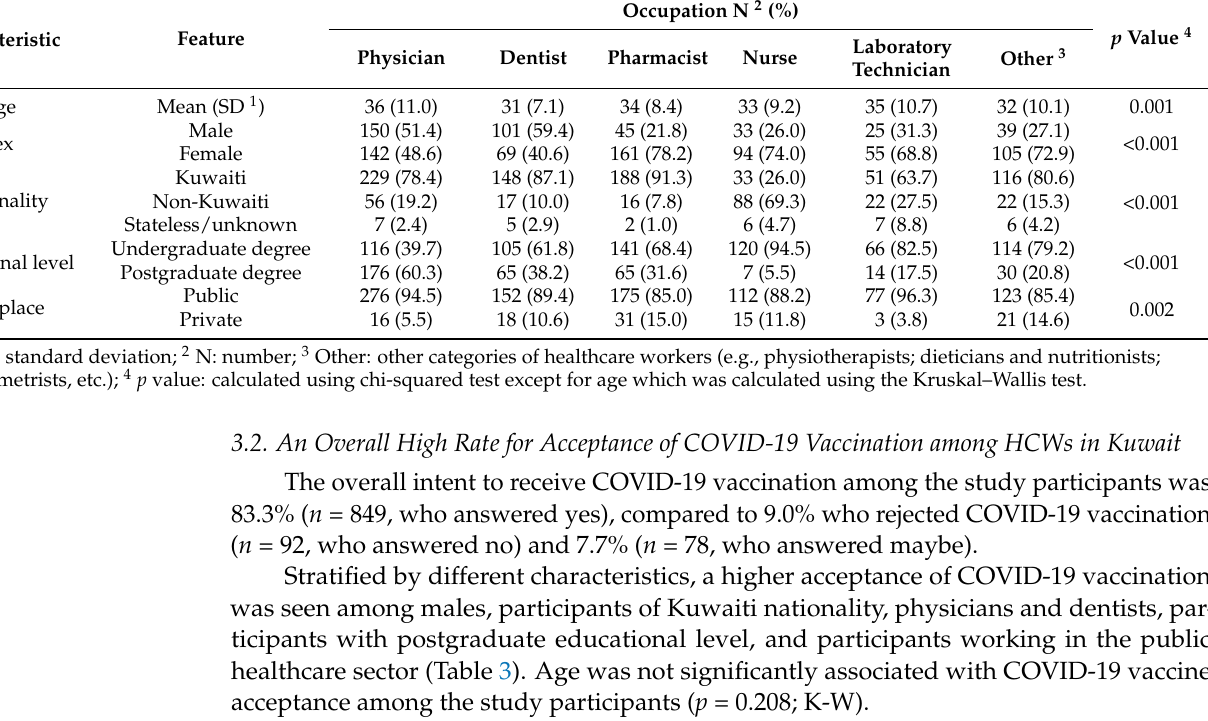
Table 2. The overall characteristics of the study participants stratified by occupation.